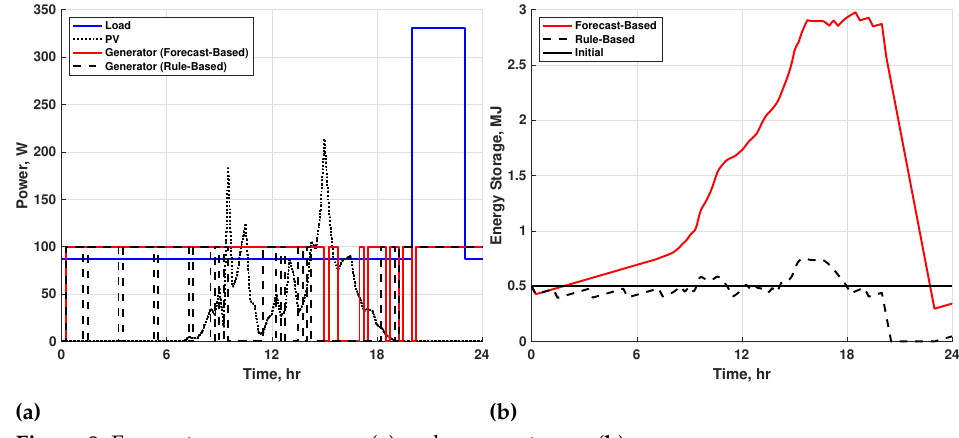
Figure 8. Forecast error case power ( a ) and energy storage ( b